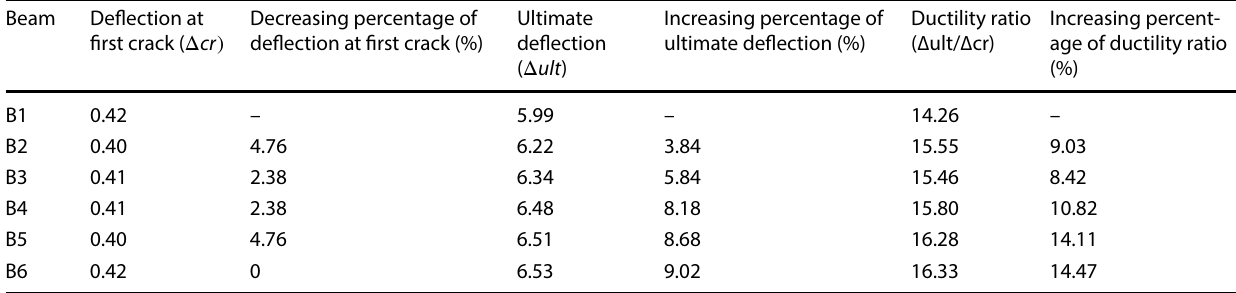
Table 6 Deflection and ductility of the tested beams Beam Deflection at first crack ( Δ cr